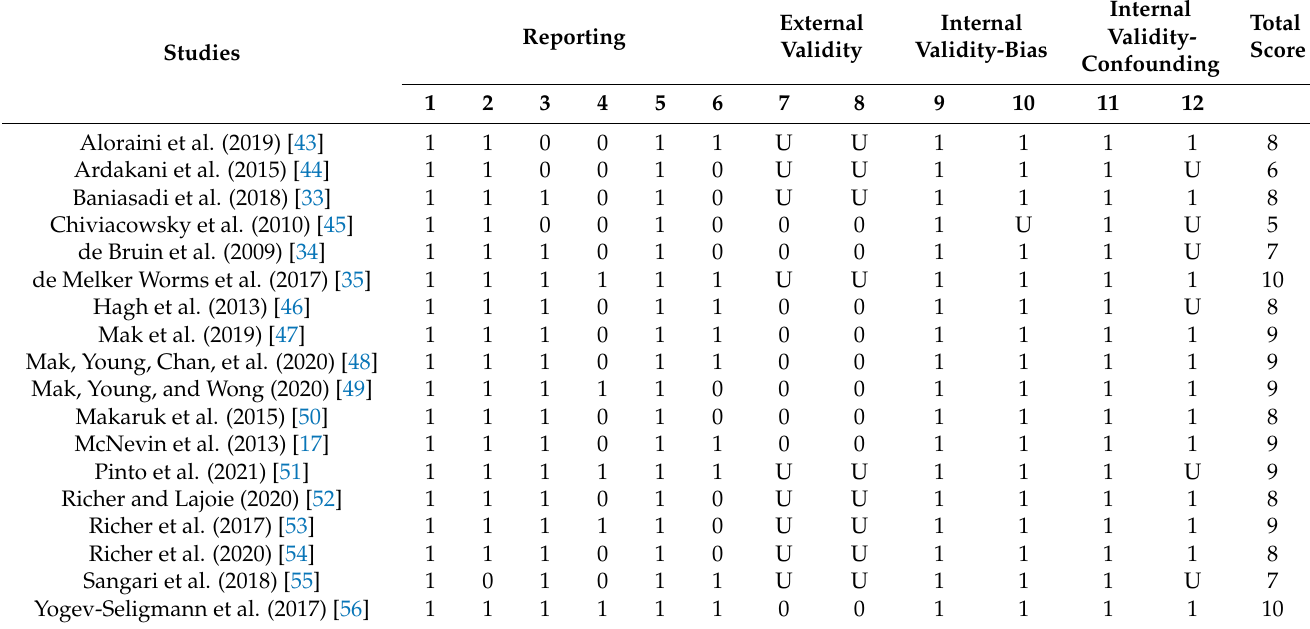
Table 2. Quality Index for Included